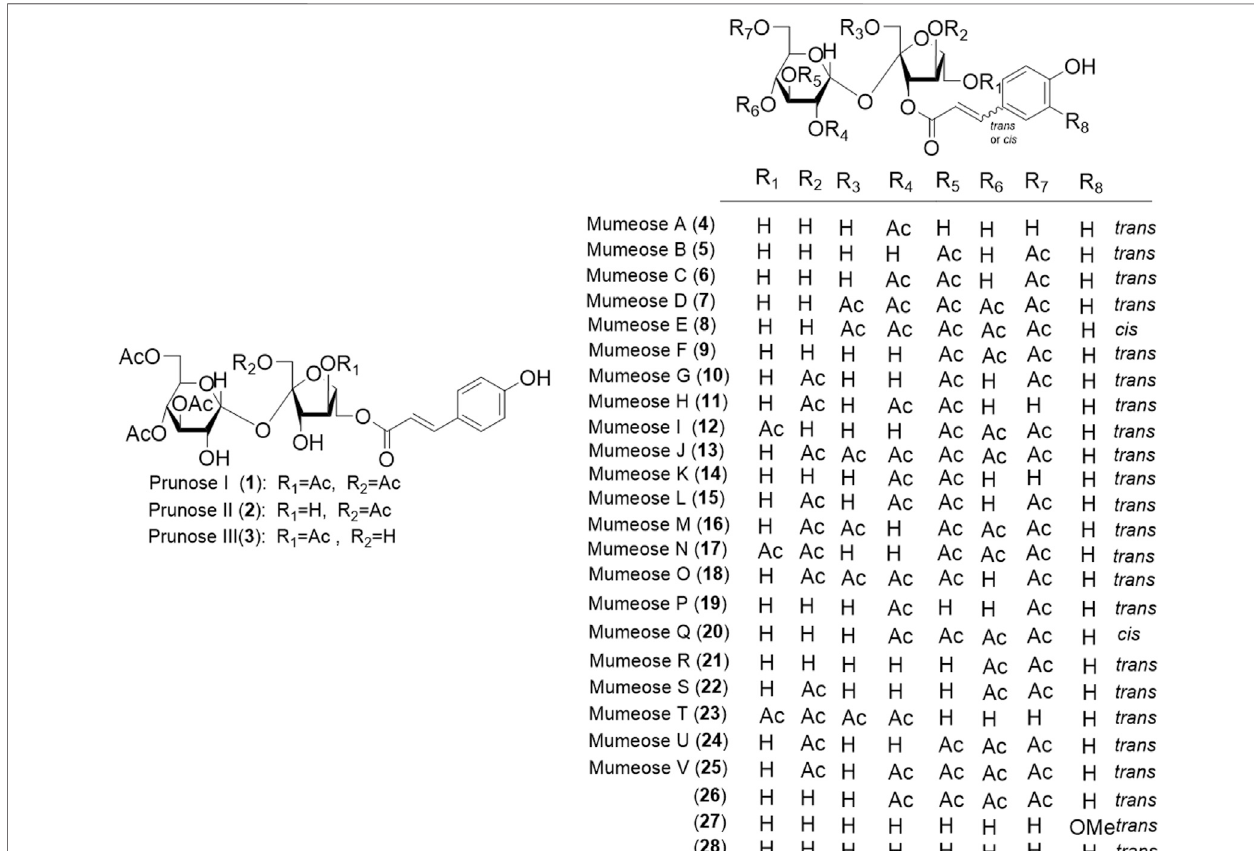
FIGURE 1 | Structures of the phenylpropanoid sucrose esters (1 – 28) form P. mume .